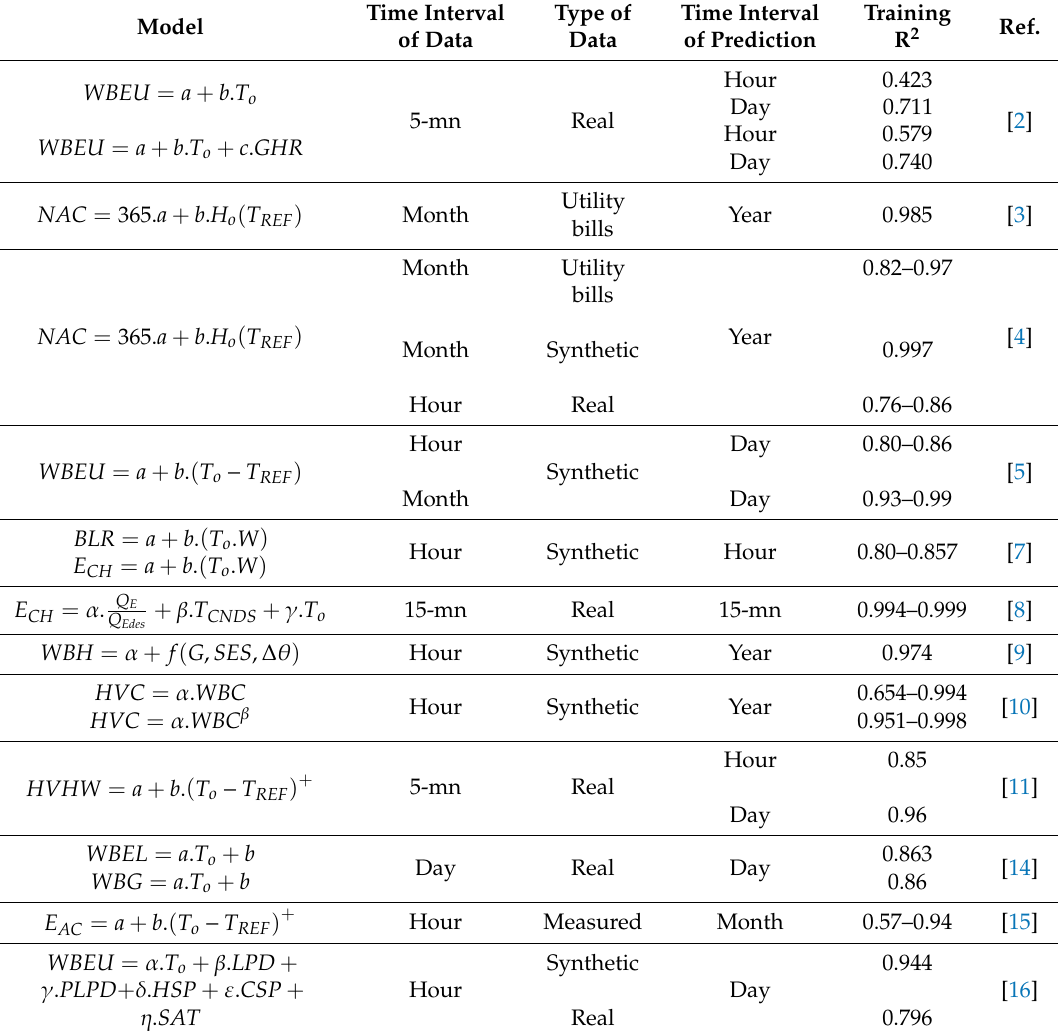
Table 1. Features of quoted benchmarking data-driven